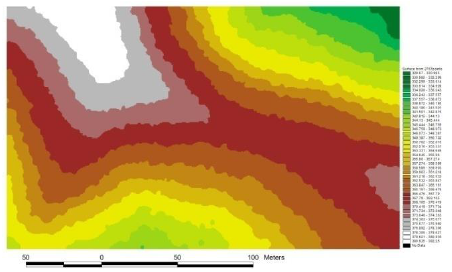
Figure 8. DEM created from reduced LiDAR data down to point cloud density of 0.067pts/m 2 .